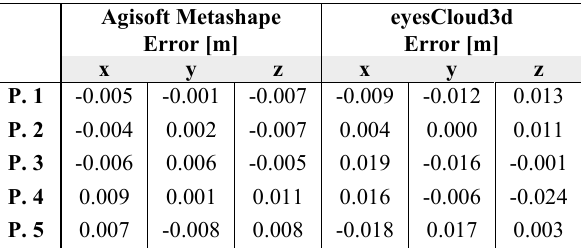
Table 2 . Deviations between laser scanner points coordinates and those of Agisoft Metashape and eyesCloud3d following manual registration.